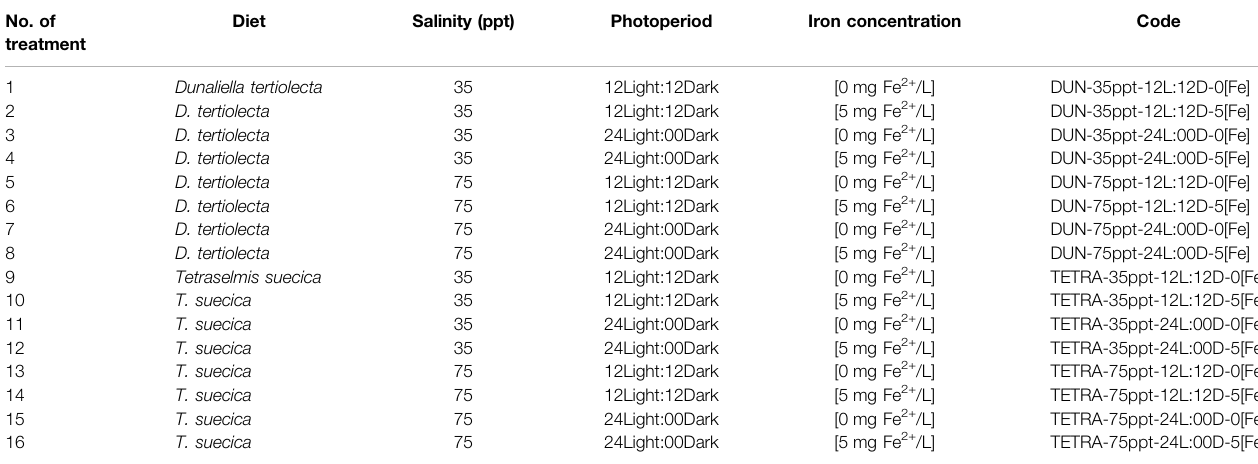
TABLE 2 | Codes used for treatments in this